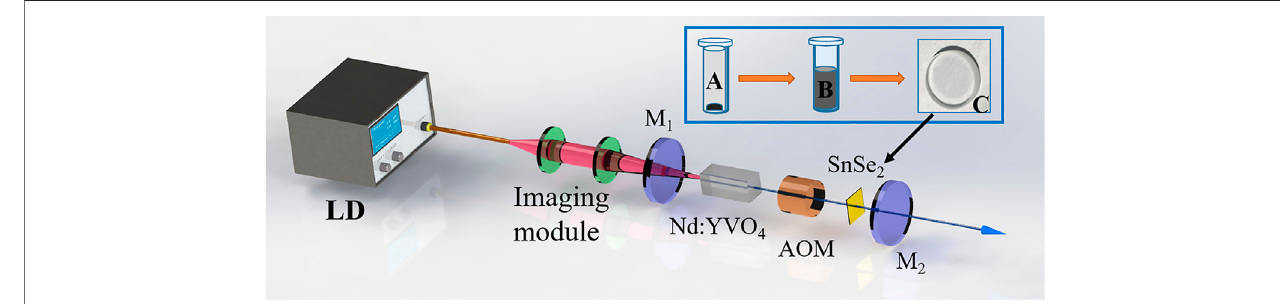
FIGURE 2 | Schematic of the doubly Q-switched laser with AOM and SnSe 2 -SA.